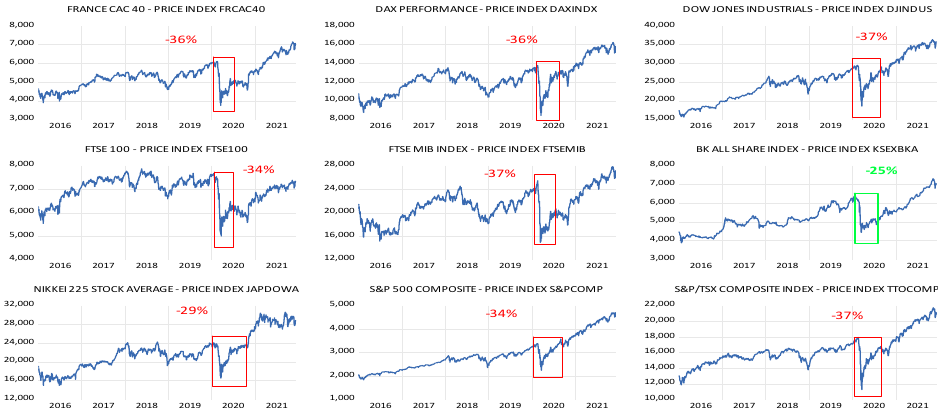
Figure 2. G7 Stock Markets Decline amidst the COVID-19 Pandemic. Note: The figure highlights the lowest points reached by the G7 leading stock markets, which were recorded on 23 March 2020. Source: DataStream